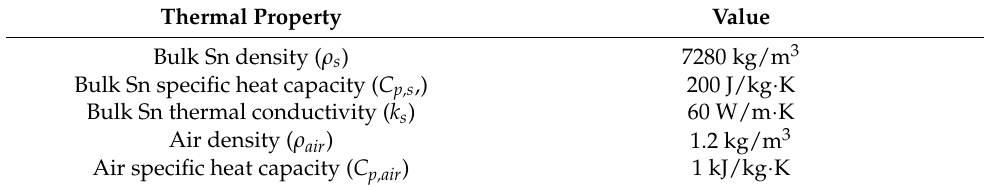
Table 1. Thermal properties of Sn and air. Thermal Property